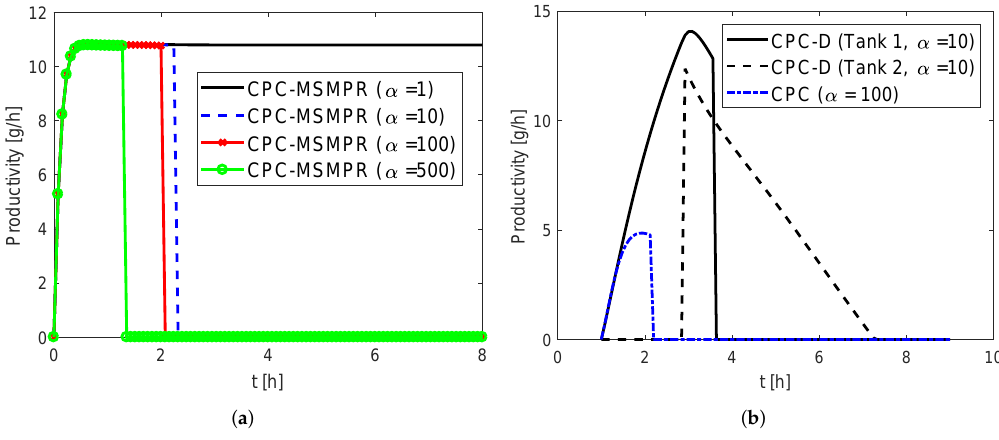
Figure 11. Simulation results showing the effect of nucleation kinetic parameters on productivity in Tank 1 for various configurations. ( a ) Results for the coupled preferential crystallization in MSMPR crystallizers (CPC-MSMPR) with incremental values of α ; ( b ) results for coupled preferential crystallization (CPC) and coupled preferential crystallization-dissolution (CPC-D)